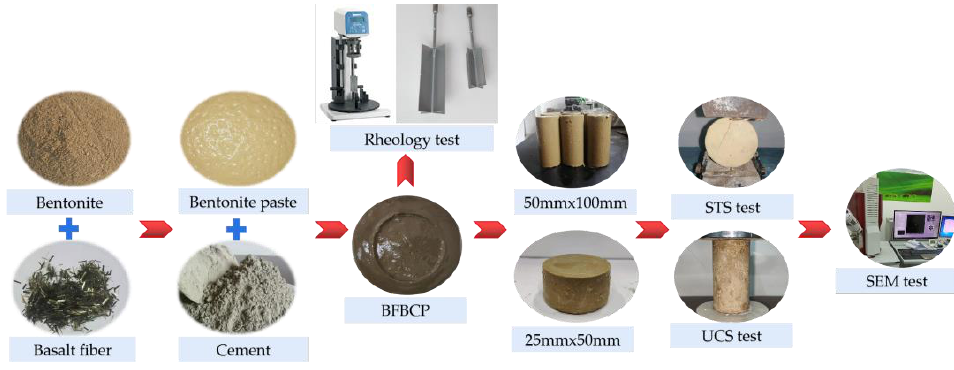
Figure 2. Schematic diagram of sample preparation and testing.